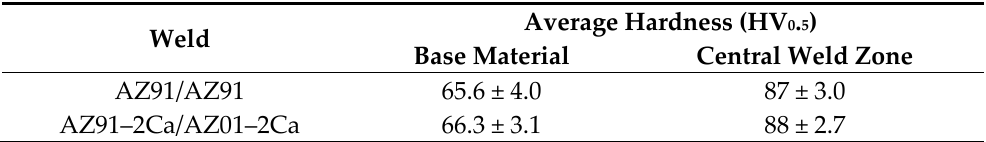
Figure 12. Vickers microhardness maps for the weld region of ( a ) AZ91/AZ91 and ( b ) AZ91– 2Ca/AZ91–2Ca welds. As the measurements approached the central weld zone, the hardness increased. Table 3. Average Vickers microhardness values for the base materials and the central weld zone in both